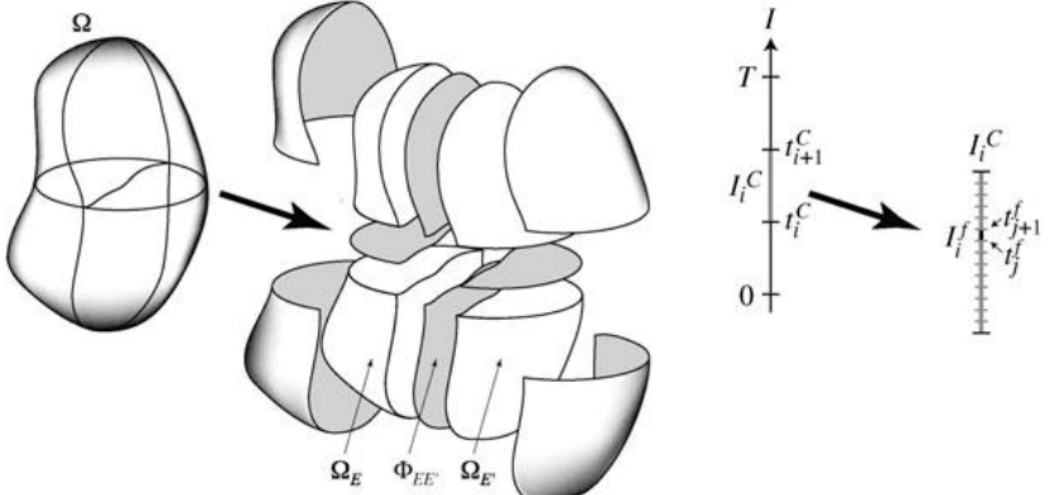
Figure 26. Substructuring of a given domain into other subdomains including interfaces and time discretization. Figure taken with permission from [132].